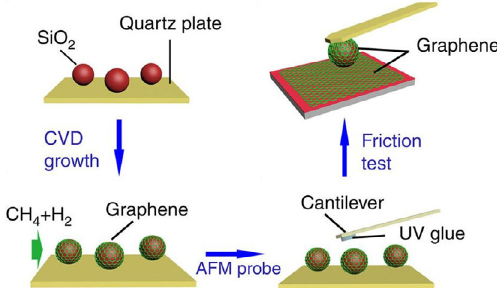
Fig. 3 Preparation of graphene-coated microspheres. Reproduced with permission from Ref. [64], © Springer Nature